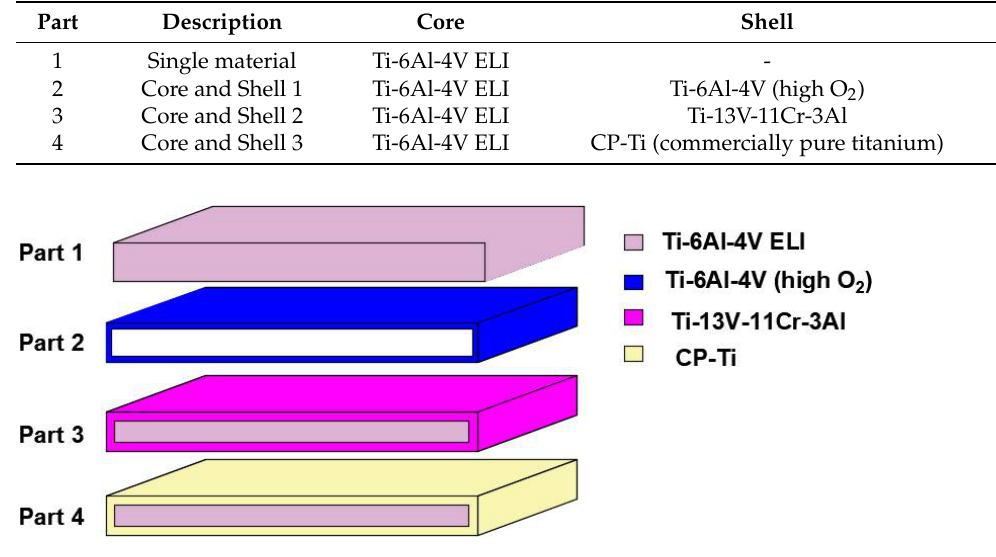
Figure 2. Billet is coated with different materials. Table 1. Initial billet material condition. Table 2. Input and output parameters of the forging in DEFORM